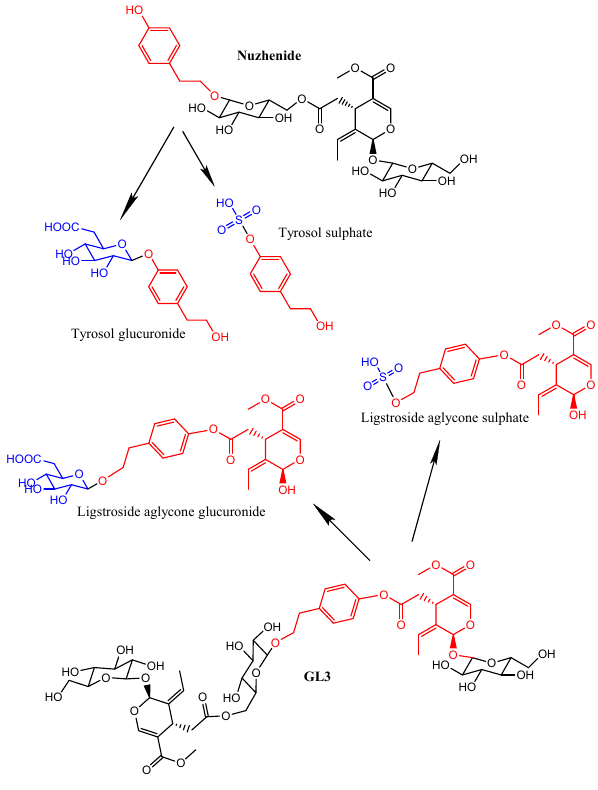
Figure 1. Chemical structures of the main secoiridoid constituents (nuzhenide and GL3) found in the Fraxinus angustifolia Vahl extract and of the specific metabolites detected in plasma and urine after the intake. The fragments originated from the hydrolysis of the secoiridoids are marked in red (tyrosol and ligstroside-aglycone). The derivatives produced by phase II conjugation are shown in blue color.